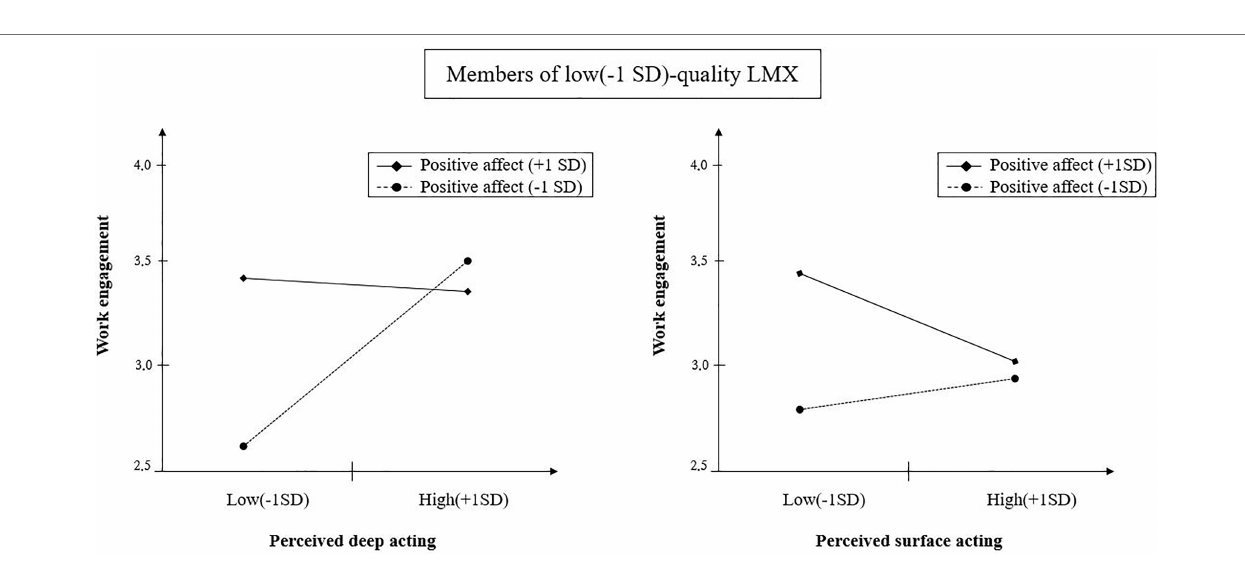
FIGURE 3 | Three-way interaction slopes with work engagement as the dependent variable for members with low-quality